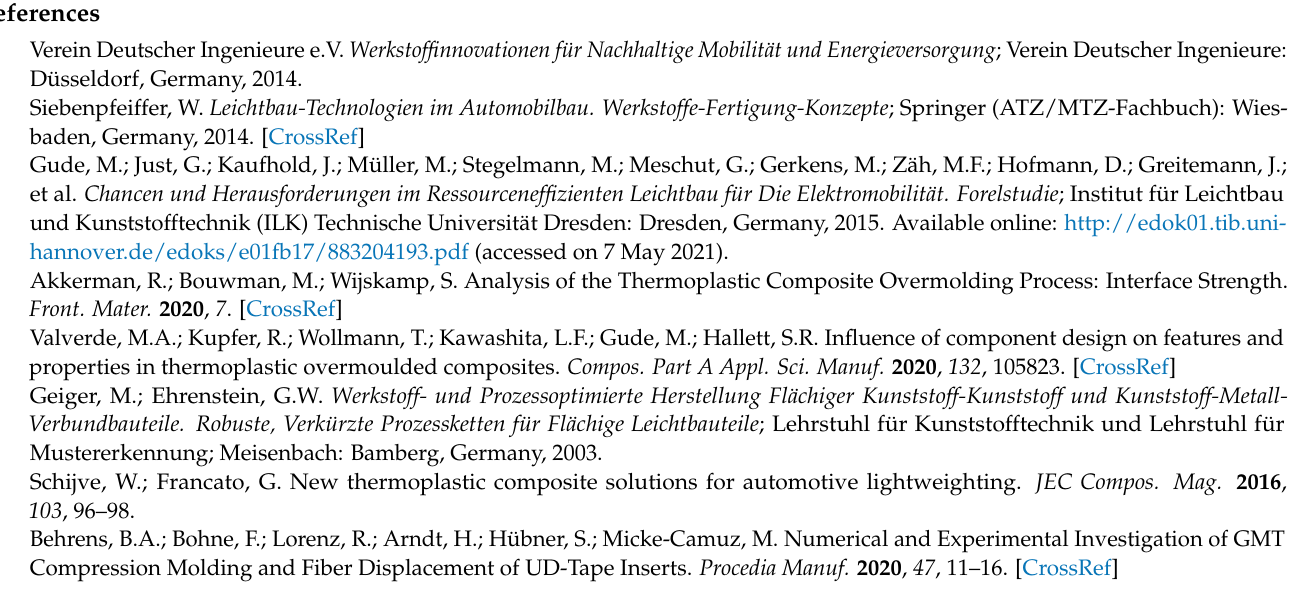
Figure A2. Results of the injection moulding simulation by means of process parameter set “HiOrg” for individual ribs of the cross-tension test specimen and final flow front after the overmoulding process.